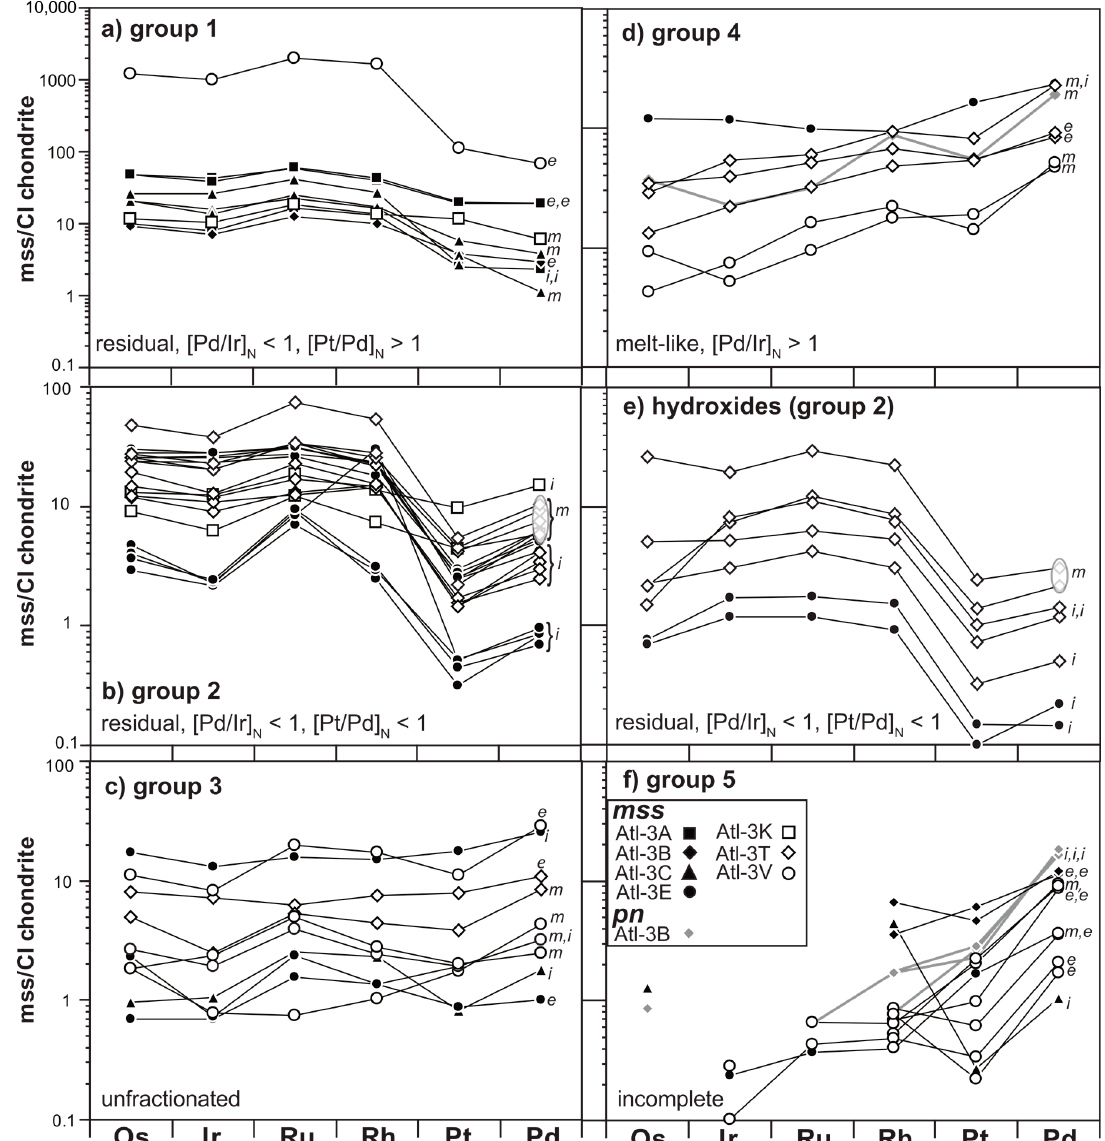
Figure 5. Chondrite-normalized [40] PGE patterns of mss and pentlandites from Middle Atlas xenoliths. Panels ( a ) and ( b ) show mss with residual PGE signatures ([Pd/Ir] N < 1), with the distinction of slight Pd enrichment for ( b ). For comparison, panel ( e ) shows hydroxides associated with group 2 mss of panel (b) . Panel ( c ) shows mss with unfractionated PGE patterns. Mss and pentlandite with melt-like PGE signatures are displayed in ( d ). Panel ( f ) shows mss and pentlandites with an incomplete PGE inventory. Letters e, i, and m indicate the textural occurrence of the sulfides as enclosed, interstitial, and associated with melt pockets.